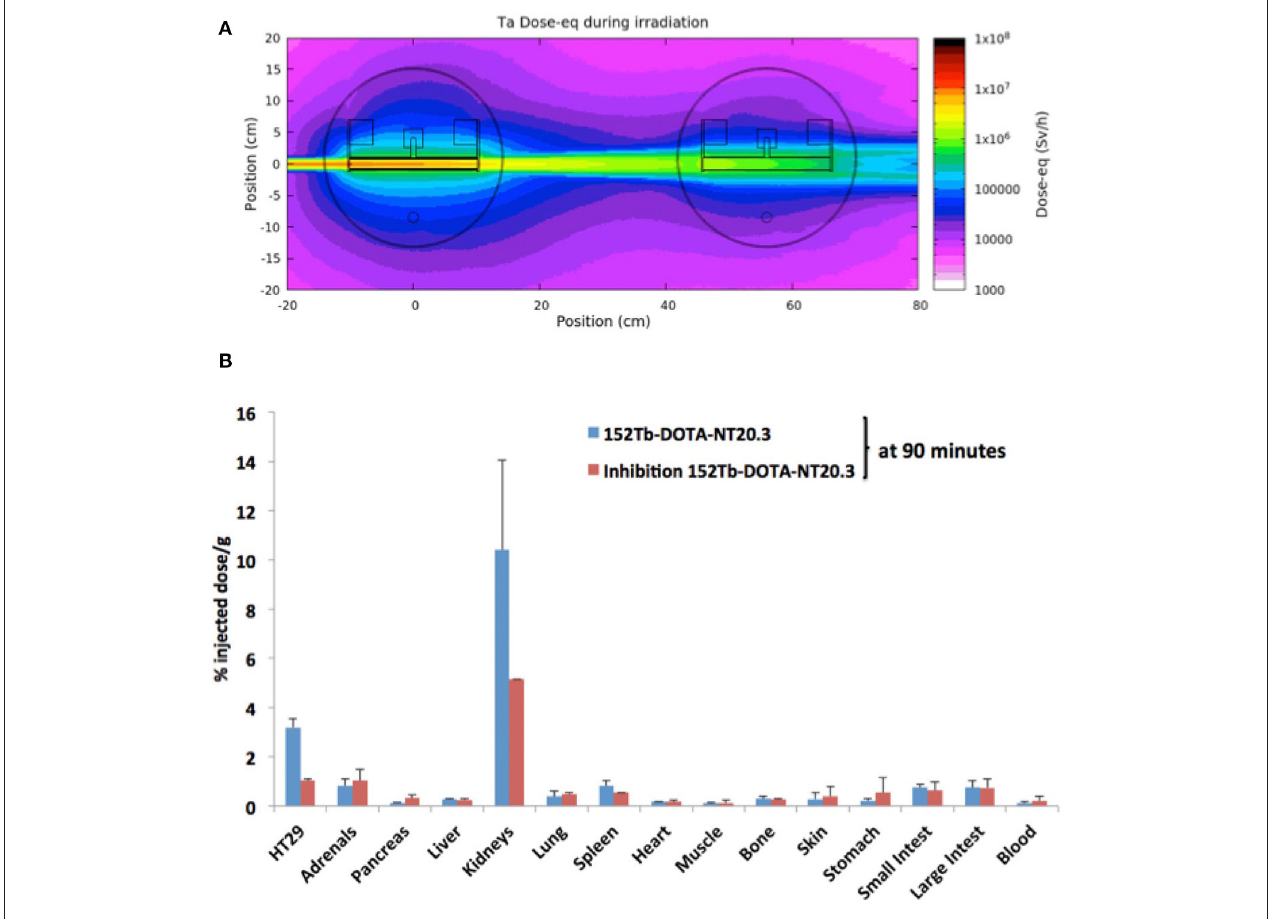
FIGURE 1 | (A) Monte-Carlo simulations of the ISOLDE (Left) and MEDICIS (Right) targets irradiated with 1.4GeV proton beam at CERN. (B) Biodistribution of Tb152 bound to the neurotensin NT20.3 at 90min post injection in mice bearing the human prostate cancer HT29 cell lines. Tumor uptake was specific as shown by the competitive inhibition experiment realized by co injection of cold radio ligand in excess. Aside the tumor the kidney also showed a strong uptake ( n = 3).